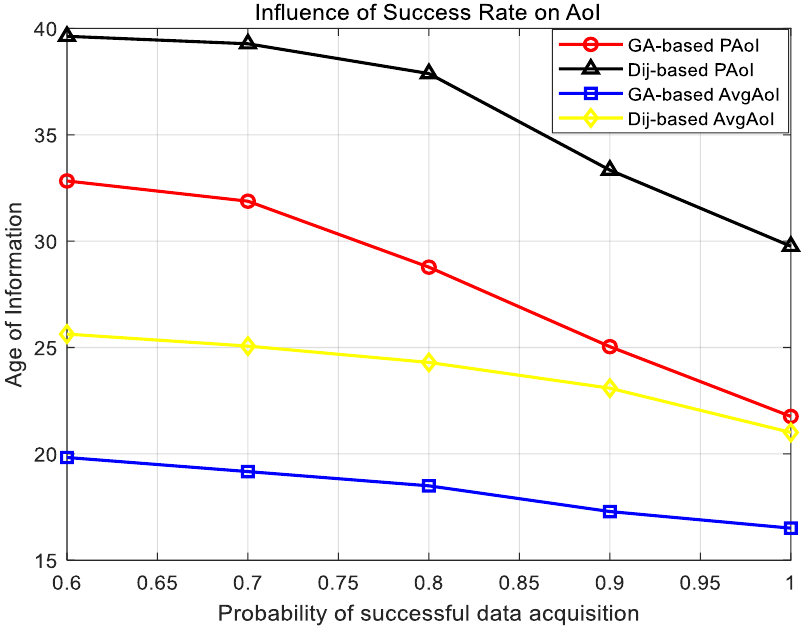
Figure 5. Influence of the data acquisition success rate on AoI.